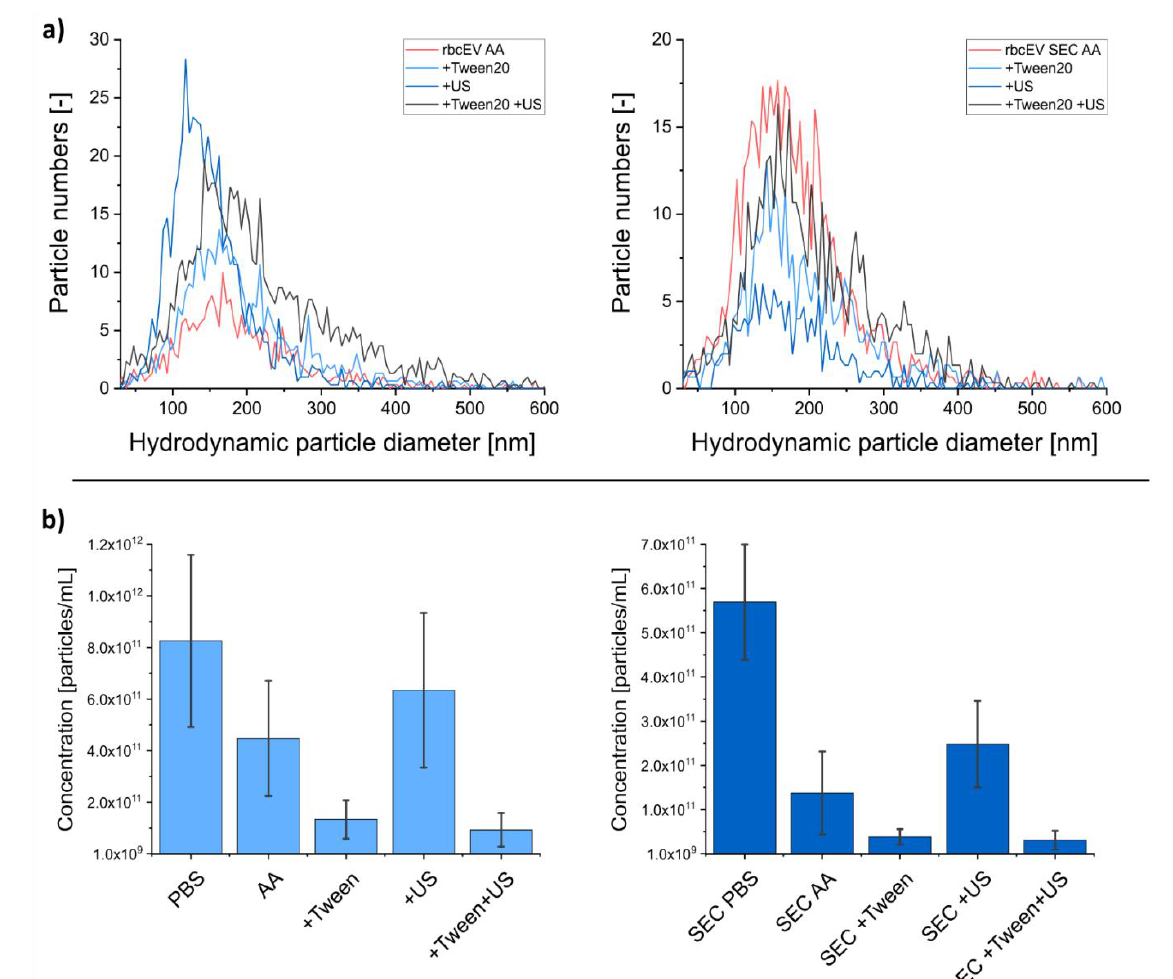
Figure 5. Influence of different treatments (Tween 20, ultrasonication (US)) on rbcEV isolates with/without size exclusion chromatography (SEC). Particle numbers and hydrodynamic particle diameters are regarded. The hydrodynamic particle diameter ( a ) of samples remains stable upon sample treatment. The impact on the particle concentration ( b ) shows loss of particle numbers after Tween 20 and ultrasonic treatments.